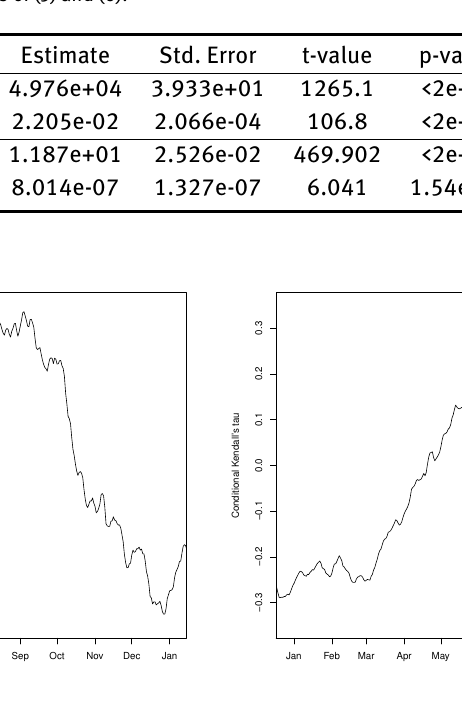
Figure 6: Conditional Kendall’s tau between the detrended electricity consumption ˆ ε 1, t and the detrended temperature ˆ ε 2, = 5 t , given the day of the year and estimated using h *